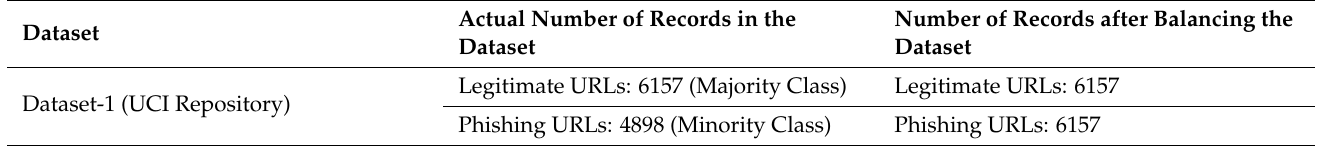
Table 7. Experiment dataset for Data Balancing